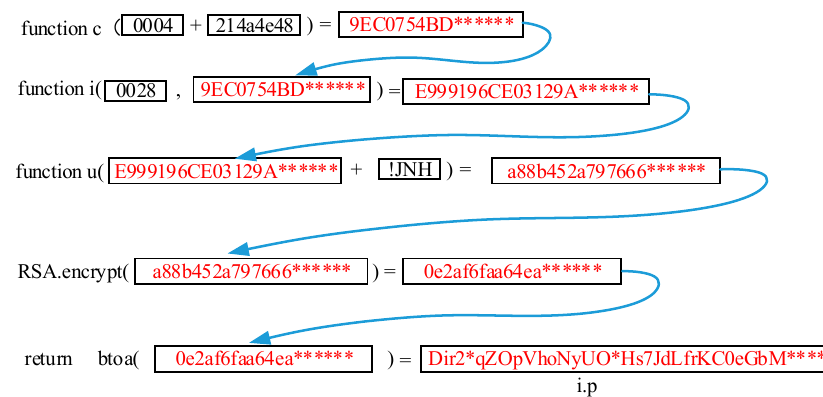
Figure 22. Dependencies of cryptographic functions of client-side implementations.